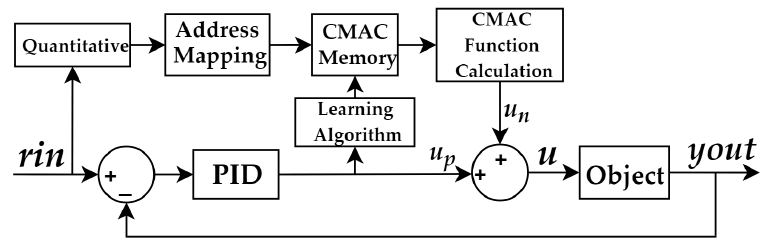
Energies 2019 , 12 , 1162 9 of 17 Figure 8. A cerebellar model articulation controller (CMAC) control structure diagram. VAS: virtual associative space; PSS: physical storage space. The CMAC design method was divided into three steps: The first step was quantization and the N -dimensional input space was divided at the input layer. Each input falls into a hypercube unit of the N -dimensional network, for any input in the middle layer, only the output of a few intervals was non-zero, and the number of non-zero intervals was the normalized parameter c . The second step was address mapping. The division remainder method was used, which mapped the input sample